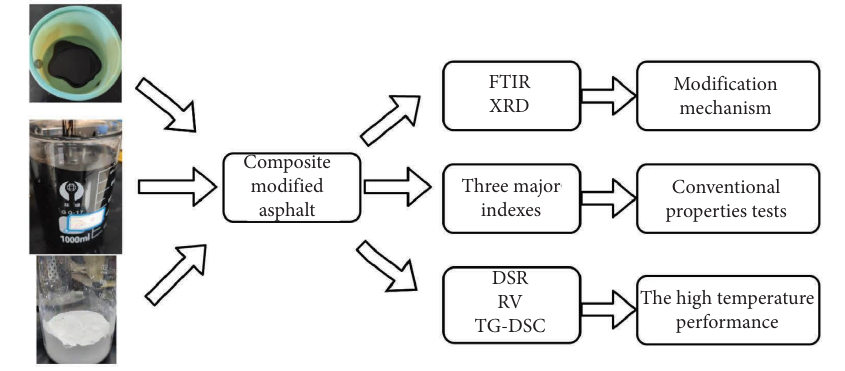
Figure 1: Te research route. Table 1: Te technical index of asphalt.